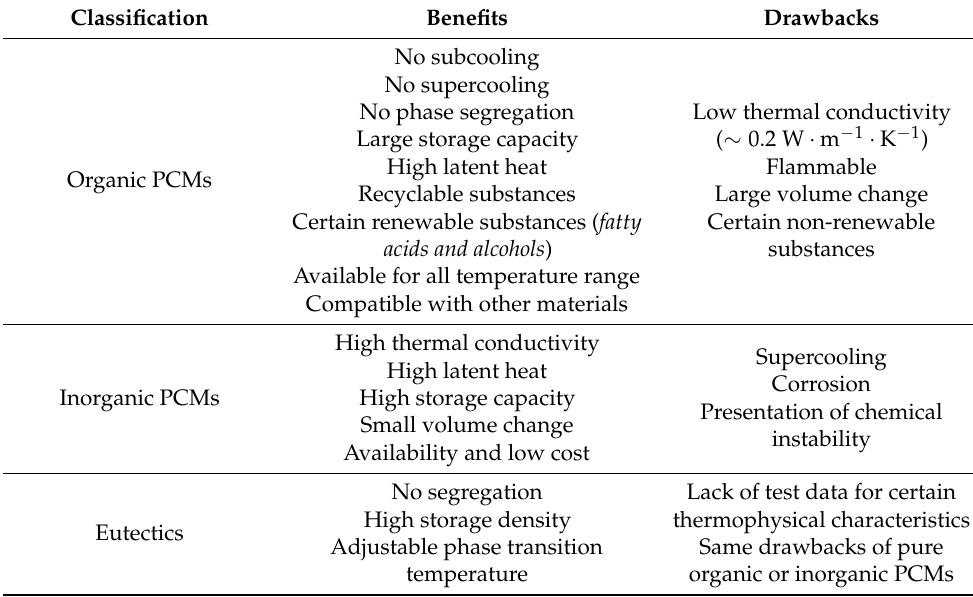
Table 5. Benefits and drawbacks of PCMs based on their classification [24,77].